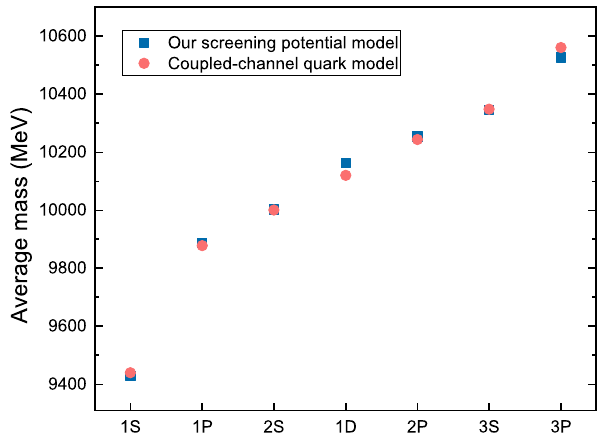
Fig. 4 A comparison of the results of our screening potential model and those obtained by a coupled-channel quark model